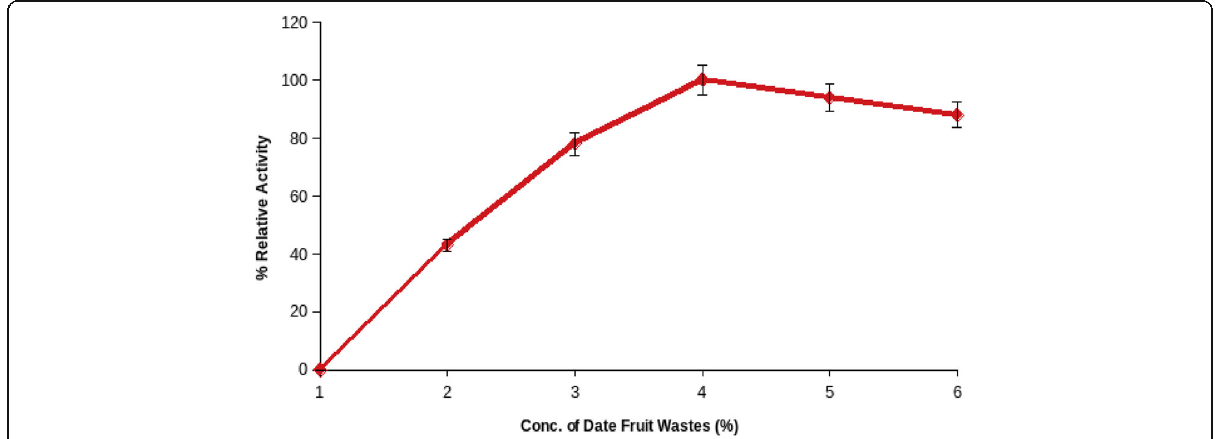
Fig. 1 The influence of date fruit waste concentration on pectinase production by B. licheniformis KIBGE-IB3 (means ± S.E., n =